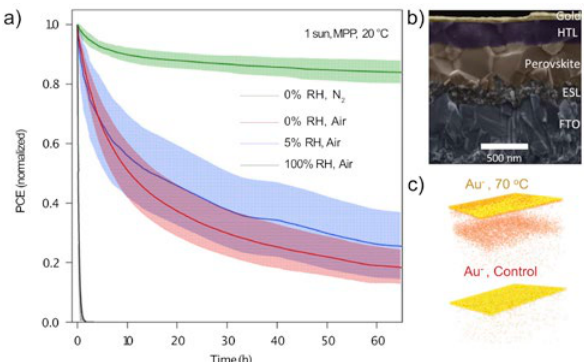
Figure 3. Aging of typical triple cation double halide perovskite solar cells. ( a) Evolution of solar-to-electric power conversion effi- ciency under operational stability conditions upon continuous irradiation by maximum power point (MPP) tracking. Adapted with permission from ref. 30 (b) Cross-sectional scanning electron microscopy (SEM) image of a typical PSC highlighting its architec- ture and (c) time of flight secondary ion mass spectroscopy elemen- tal depth profiling image showing the concentration of Au species across the device, indicative of ion migration under operational conditions at elevated temperatures. Adapted with permission from ref. 30 Copyright 2016 American Chemical